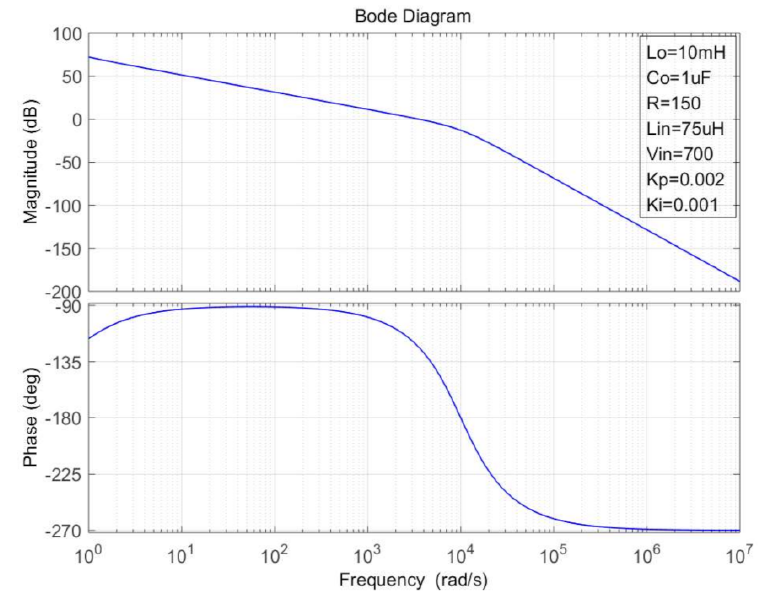
Figure 16. Loop gain with PI compensation.